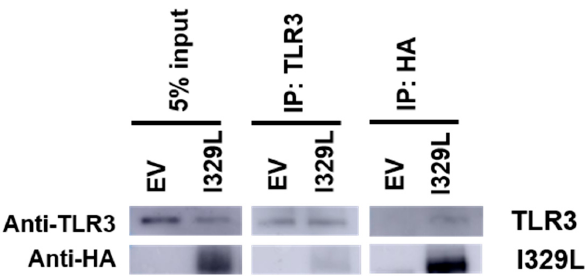
Figure 6. The I329L interacts with TLR3. HEK-293T cells stably expressing control and I329L were transfected with TLR3. After 48 h, cell lysates were subjected to immunoprecipitation using antibodies for TLR3 or HA (to capture I329L). The immunoprecipitates were then analyzed for the presence of I329L and TLR3 by Western blot.